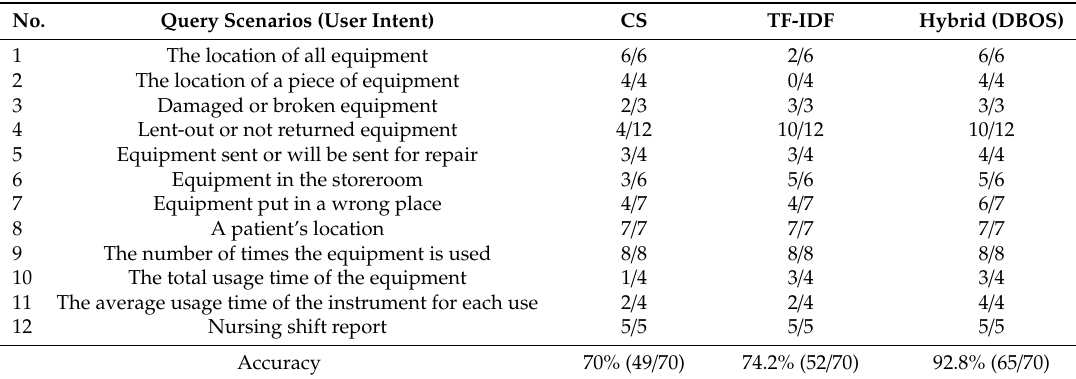
Table 2. The accuracy of di ff erent